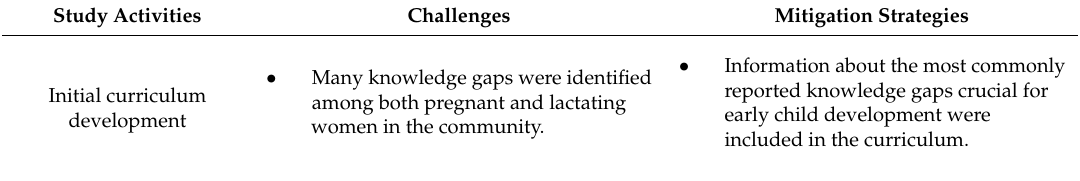
Table 4. Lessons learned and mitigation